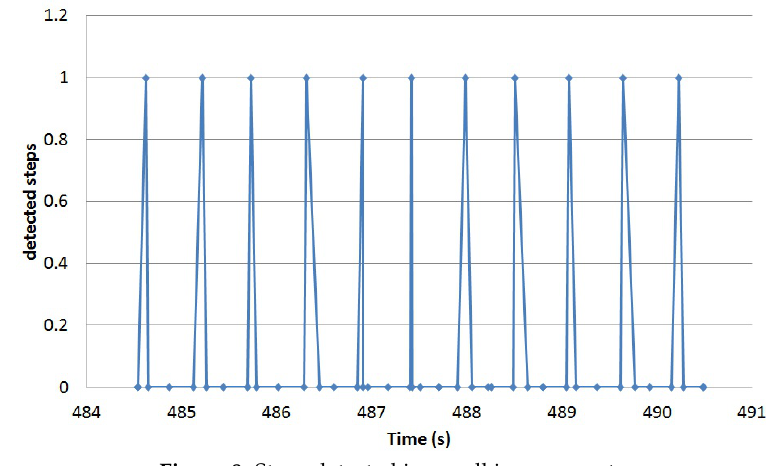
Figure 8. Steps detected in a walking segment.